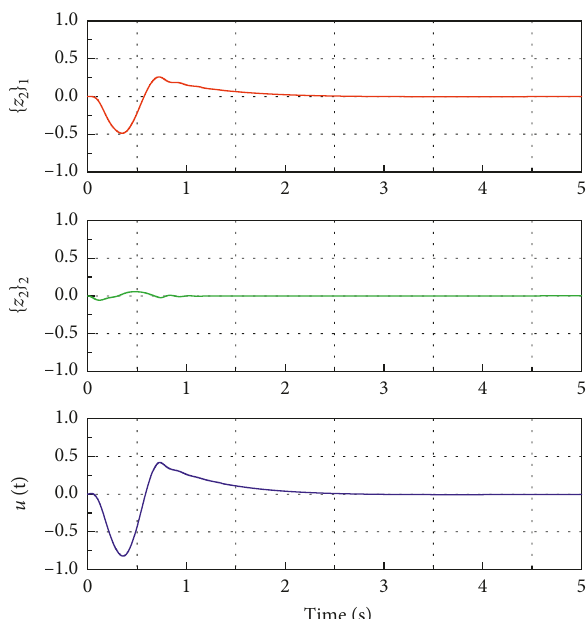
Figure 6: Constraint outputs of the proposed control under the shock road disturbance.